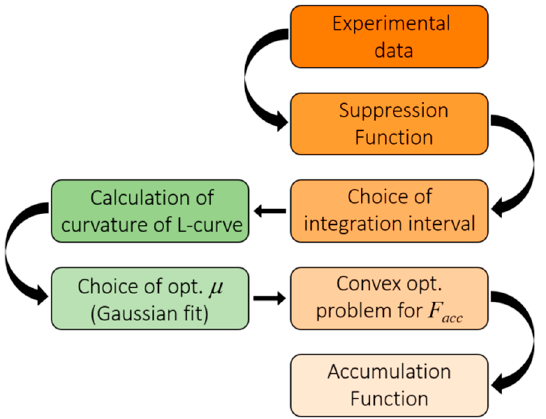
Figure 1. Flow-chart of the reconstruction method used to obtain the accumulation function from experimental data.